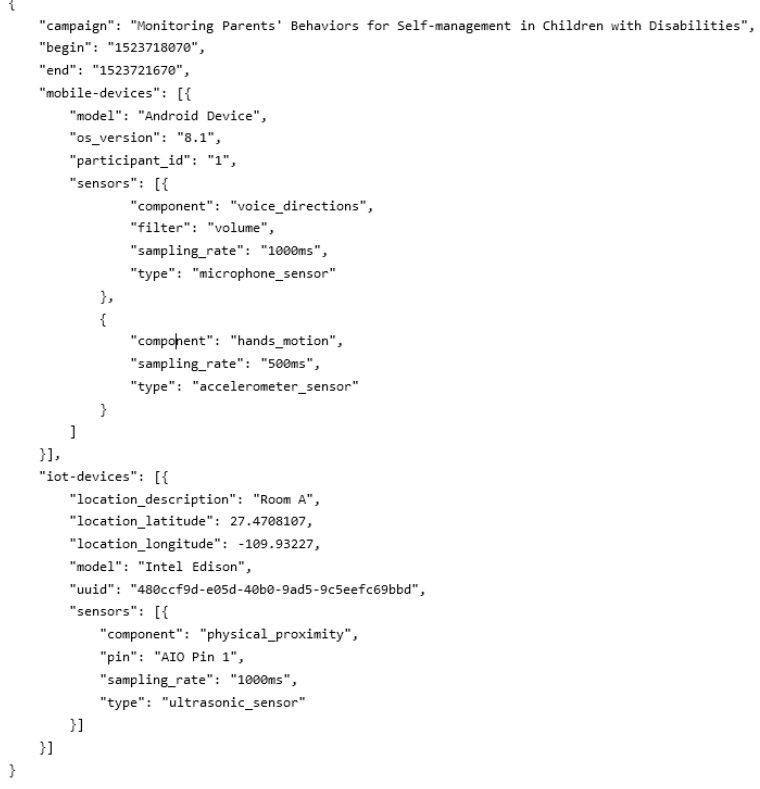
Figure 7. JSON representation of the sensing